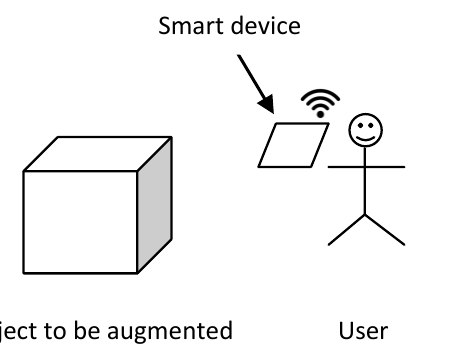
Figure 1. Conceptual illustration of third person perspective augmented reality (TPP AR) adopted by our